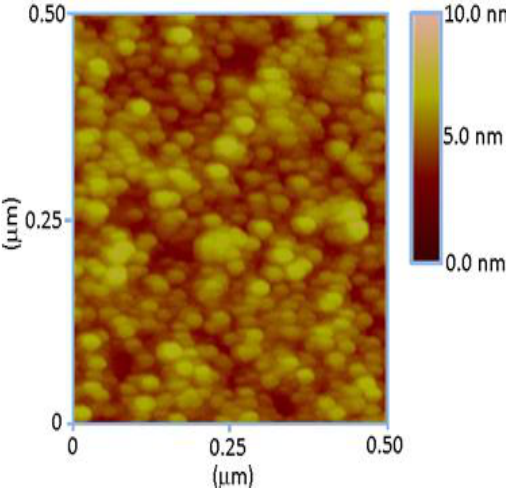
Figure 4. The AFM image of the 70 mg ZnO nanoparticles present in the chitosan solution.